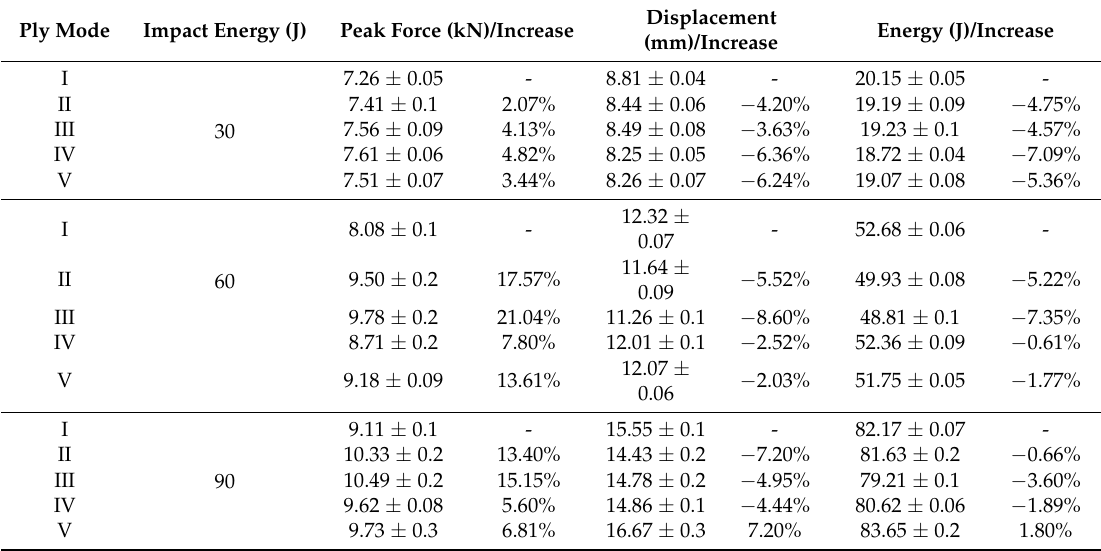
Table 4. Average values of the impact response and the increase compared to the reference laminate. Ply